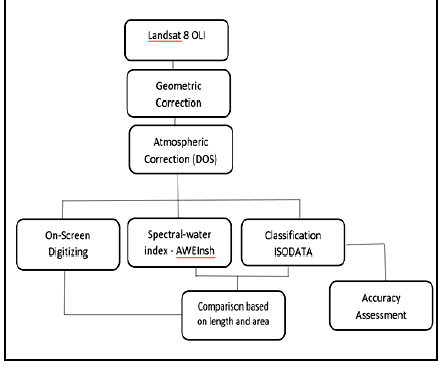
Figure 2. Flowchart of the